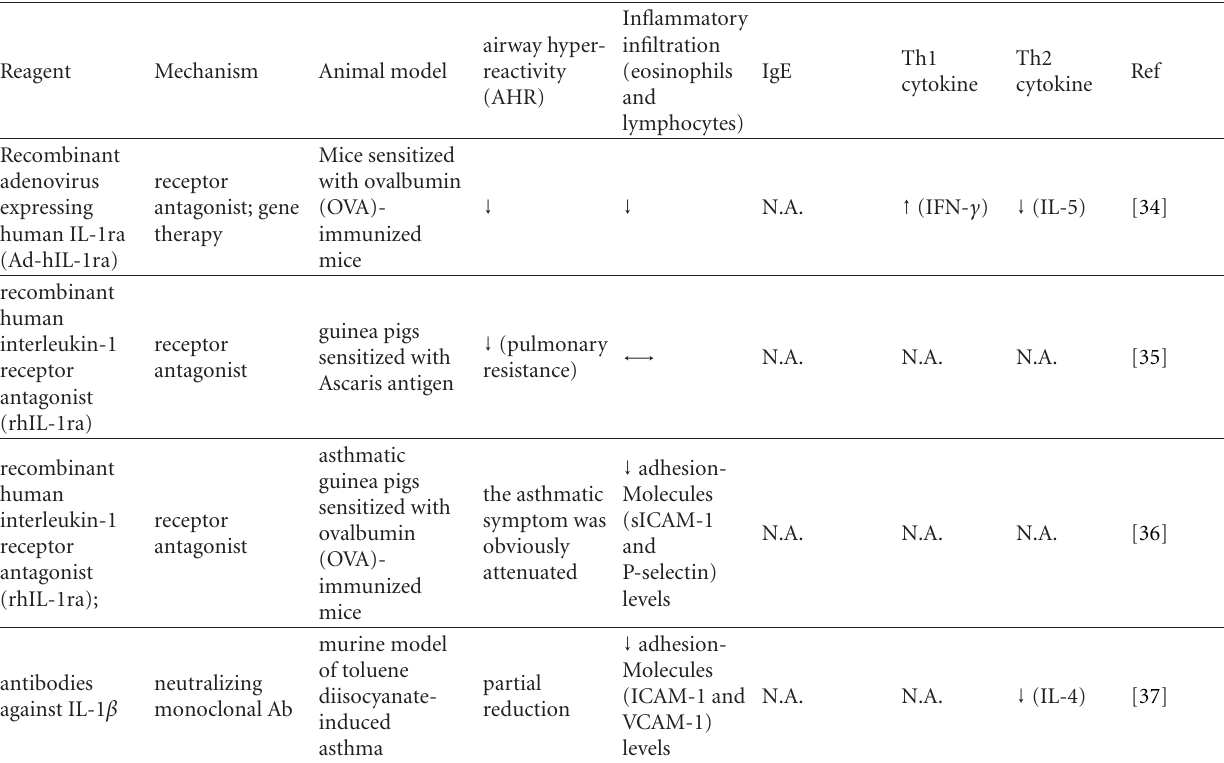
Table 1: E ff ect of therapeutic experiments Targeting IL-1RI/IL-1